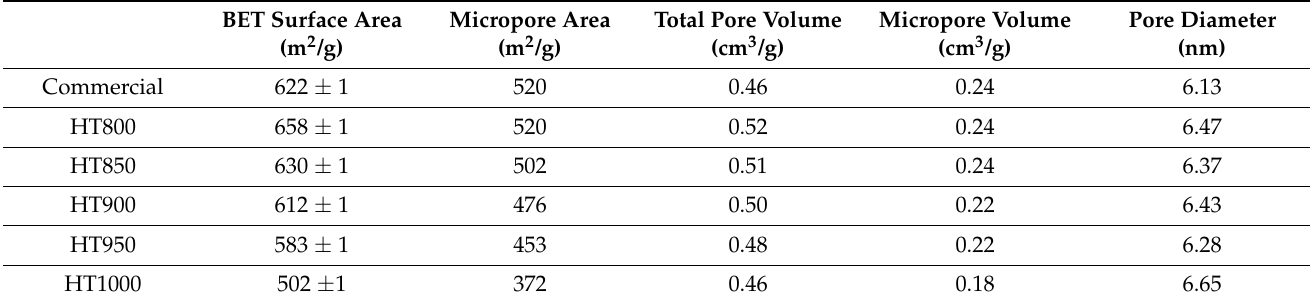
Table 8. Nitrogen adsorption parameters for the different activated